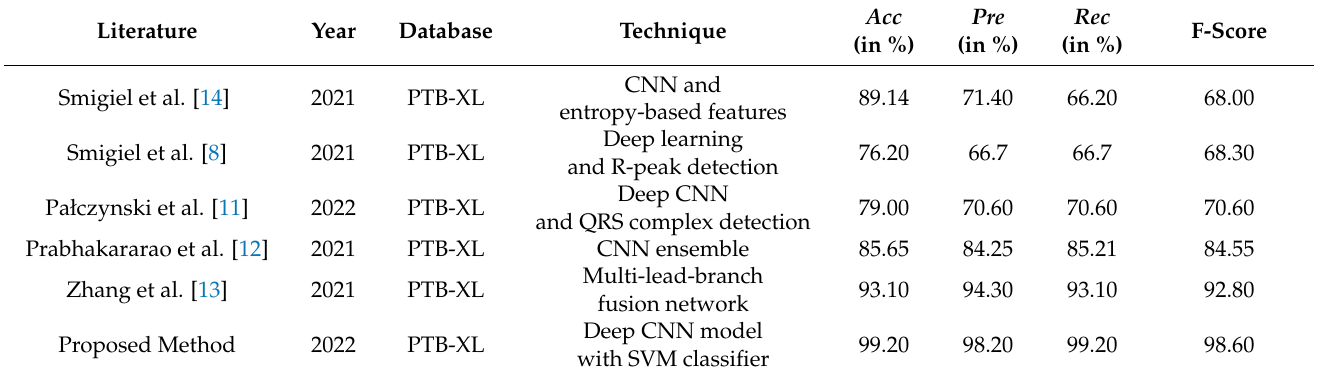
Table 8. Comparison between the proposed deep CNN method and other recent